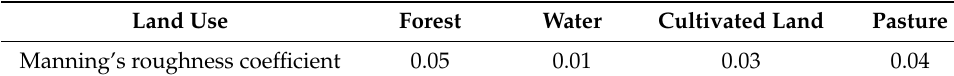
Figure 17. The classification of land-use types. Table 1. The Manning’s roughness coefficients of different land types.